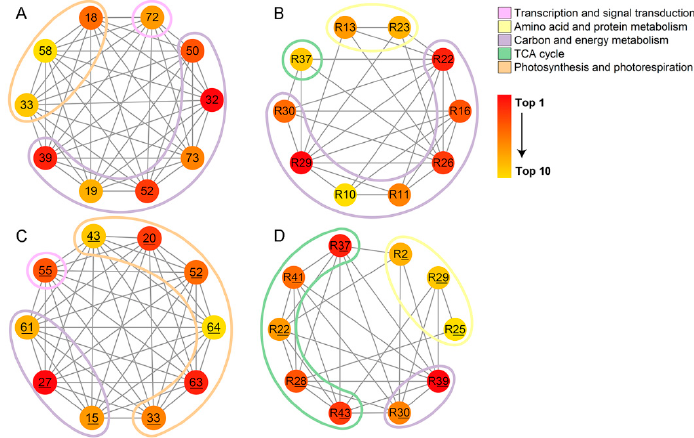
Figure 6. Top 10 hub proteins in network of ( A ) A. ilicifolius leaves, ( B ) A. ilicifolius roots, ( C ) A. mollis leaves, and ( D ) A. mollis roots ranked by Matthews correlation coefficient (MCC) method. R represents the root tissue. Underlined numbers represent A. mollis tissues. Int. J. Mol. Sci. 2021 , 22 , x FOR PEER REVIEW